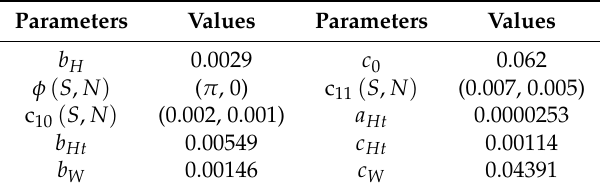
Table 1. Parameters for Vienna mapping functions.